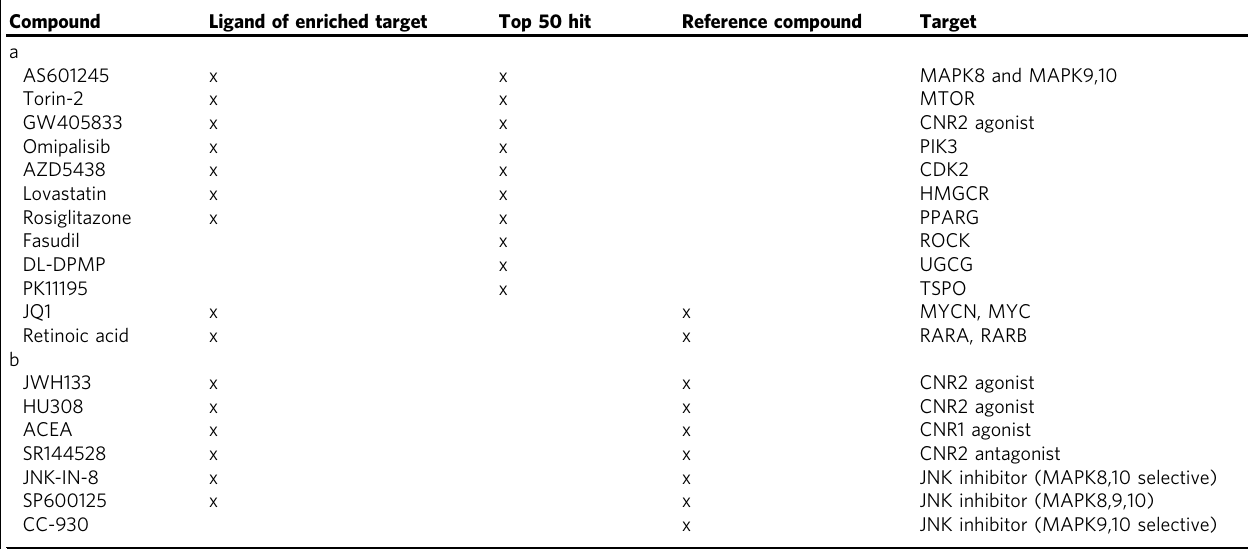
Table 2 Compounds used to evaluate TargetTranslator